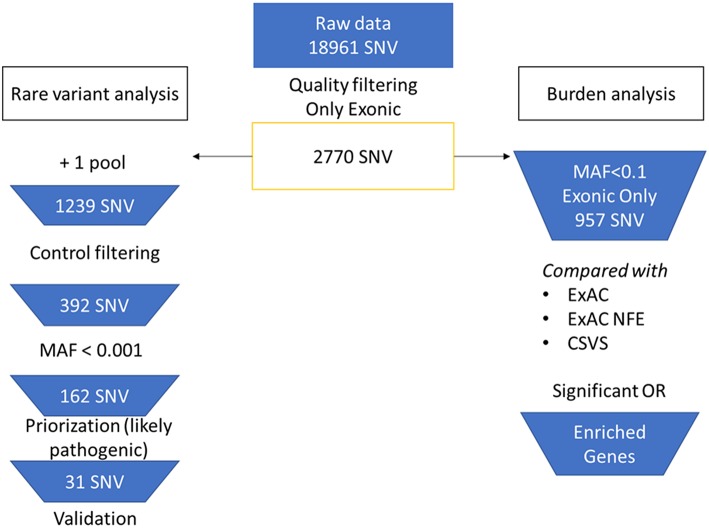
Flowchart of the bioinformatic analysis. On the left branch, rare variant analysis and priorization workflow. On the right branch, burden analysis of selected variants.